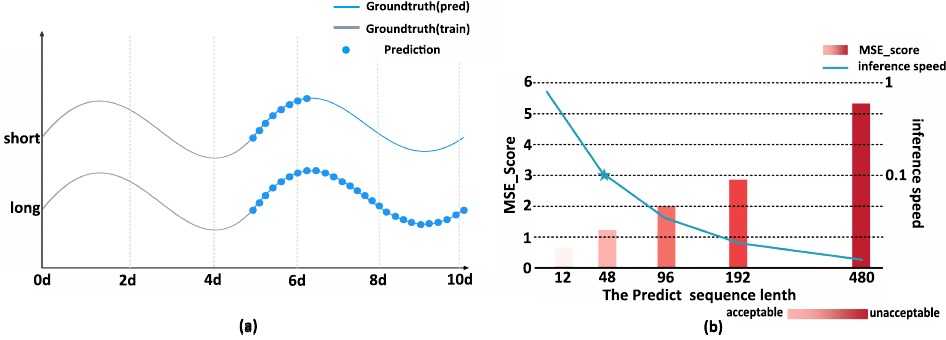
Figure 3. ( a ) Comparison of the limit sequence lengths that can be predicted by LSTF and SSTF. ( b ) Prediction length and accuracy of prediction results.